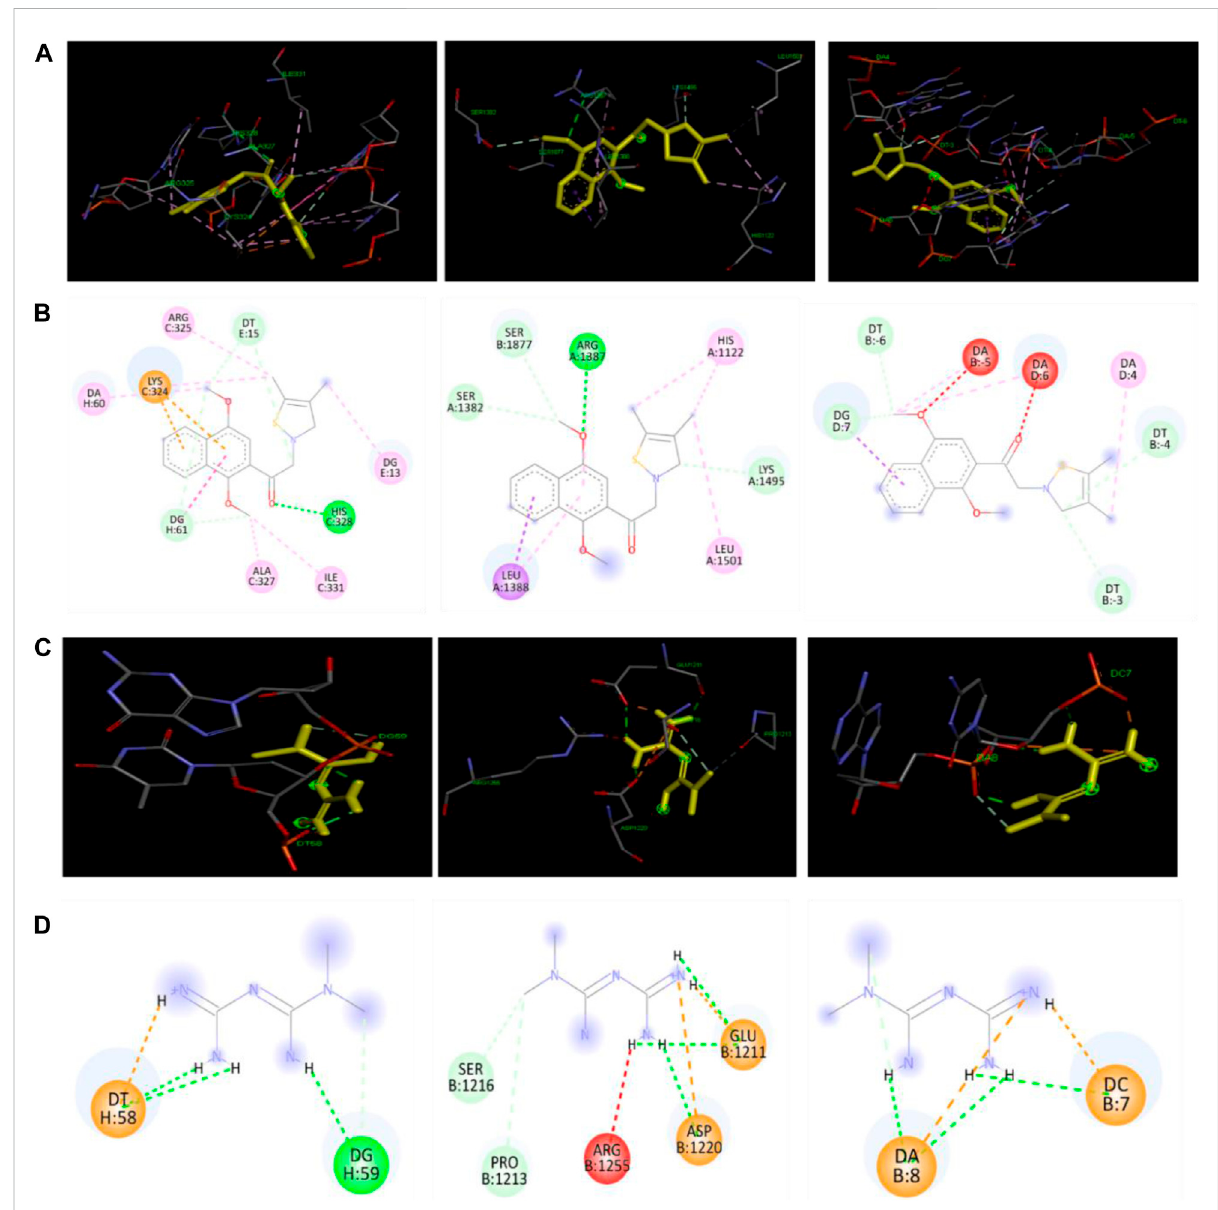
FIGURE 9 Docking interactions of KAHG-04 and metformin with SREBP1C, FAS, and C/EBP α . (A) 3D interaction of KHAG-04 (dark Yellow) with SREBP1C (left panel), FAS (middle panel), and C/EBP α (right panel). (B) 2D structural presentation of the amino acid residues and nucleotides interaction of KHAG-04 with SREBP1C (left panel), FAS (middle panel), and C/EBP α (right panel). (C) 3D structural interaction of metformin with SREBP1C (left panel), FAS (middle panel), and C/EBP α (right panel). (D) 2D structural presentation of the amino acid residues and nucleotides interaction of metformin (dark Yellow) with SREBP1C (left panel), FAS (middle panel), and C/EBP α (right panel). Bold green dot lines represent a conventional hydrogen bond, lightgreen dot lines represent a carbon – hydrogen bond, pink dot lines represent a Pi-Pi sigmabond, light pink dot lines represent a Pi-alkyl bond, brown dot lines represent aPi-cation bond, red dot lines represent an unfavorable acceptor-acceptor bond, and light yellow dot lines represent a salt bridge bond. All data shown here are from three independent